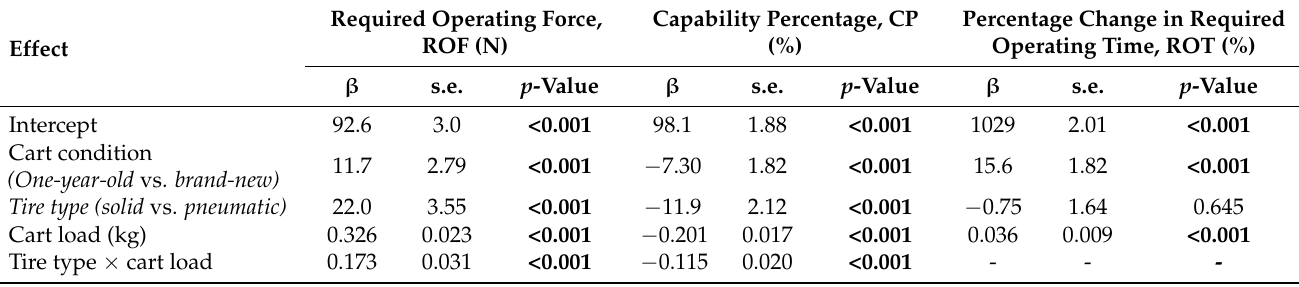
CP, and ROT. Bold fonts indicate p -values are less than our significance level